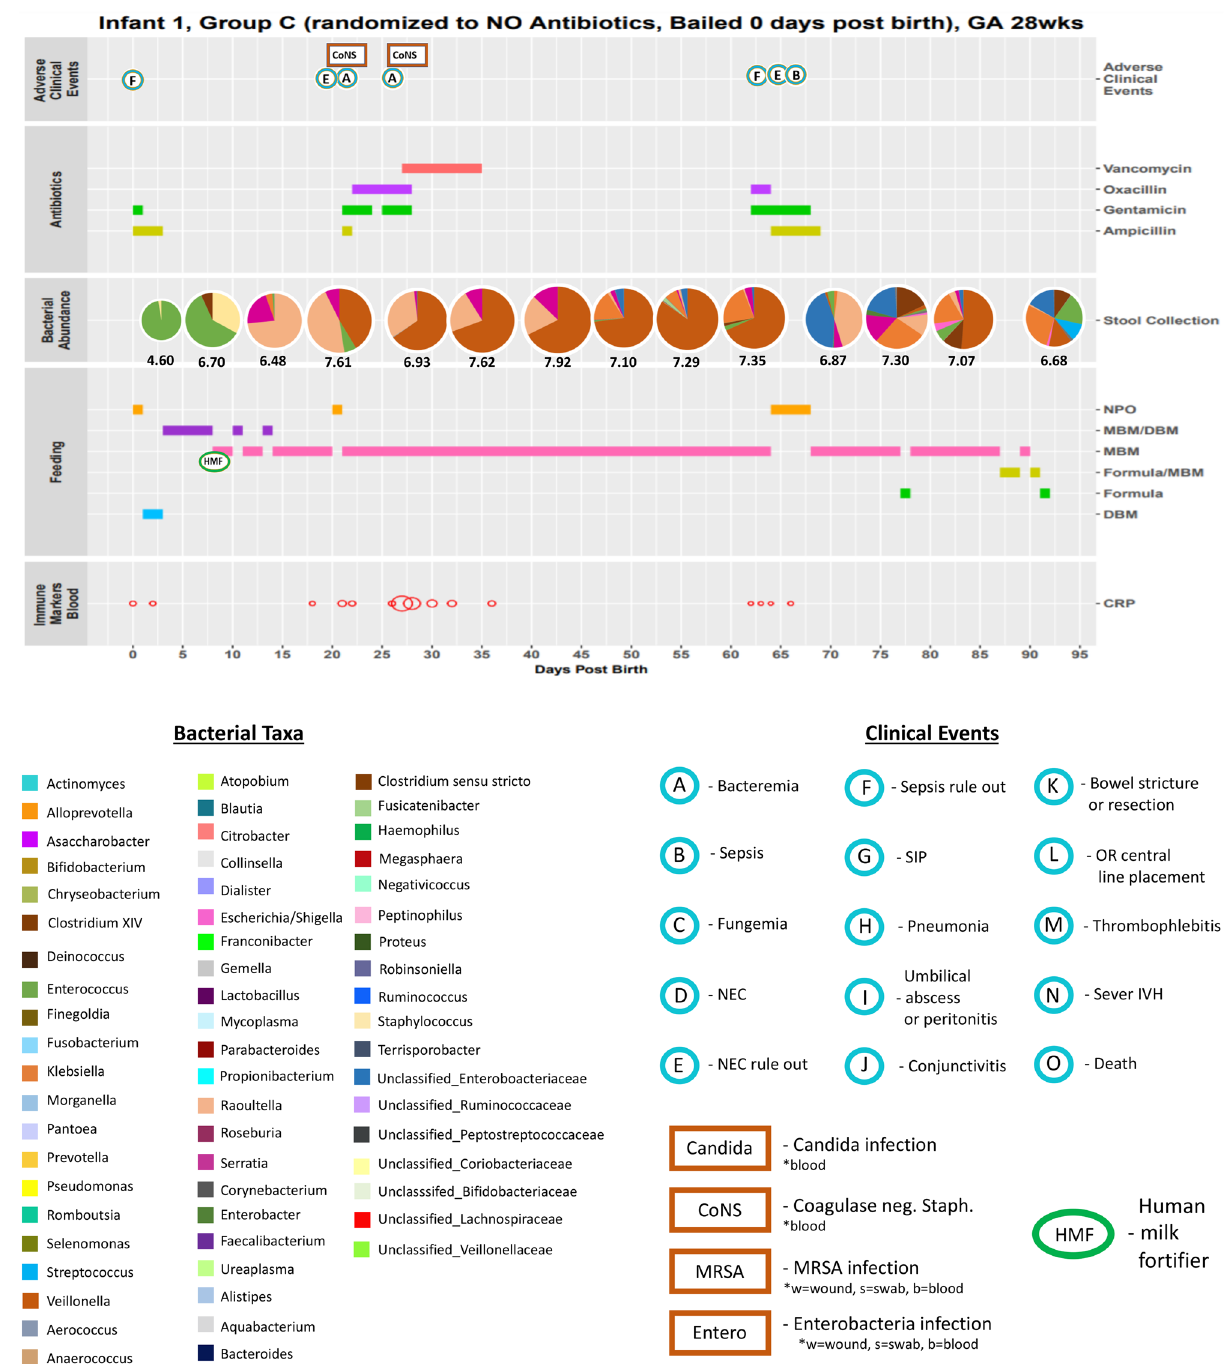
Figure 5. Integration of clinical and laboratory data gives detailed view of infant stay in NICU. Extensive clinical and laboratory data, when combined, provide a detailed summary of each infant’s stay in the NICU. Data included in each chart from top to bottom include: the infant ID, group assignment, antibiotic change status (bail), gestational age, any adverse clinical events (which are further described in Supplementary Figure S1), the type and duration of antibiotic use (if any), the copy-number corrected absolute composition of each weekly stool sample and it’s log 10 -scale number of bacterial 16S rRNA copies, the type and duration of each feeding including administration of human milk fortifier, the relative levels of C-reactive protein measured from blood, and relative concentrations of measured stool immune markers (for infants where these measurements were performed). DBM: donor breast milk, MBM: mother’s breast milk, NPO: no enteral nutrition, CRP: C-reactive protein, EGF: epidermal growth factor. Listed below is a key for the color-coded bacterial taxa used in the stool 16S rRNA copy-number corrected composition pie chart for each infant chart. A key for the bacterial color codes, adverse clinical events (including infections by body site) and the administration of human milk fortifier for each infant chart is given